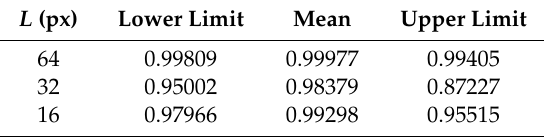
Table 2. NSE coe ffi cient of the statistical profiles obtained with 20 3 and 5 3